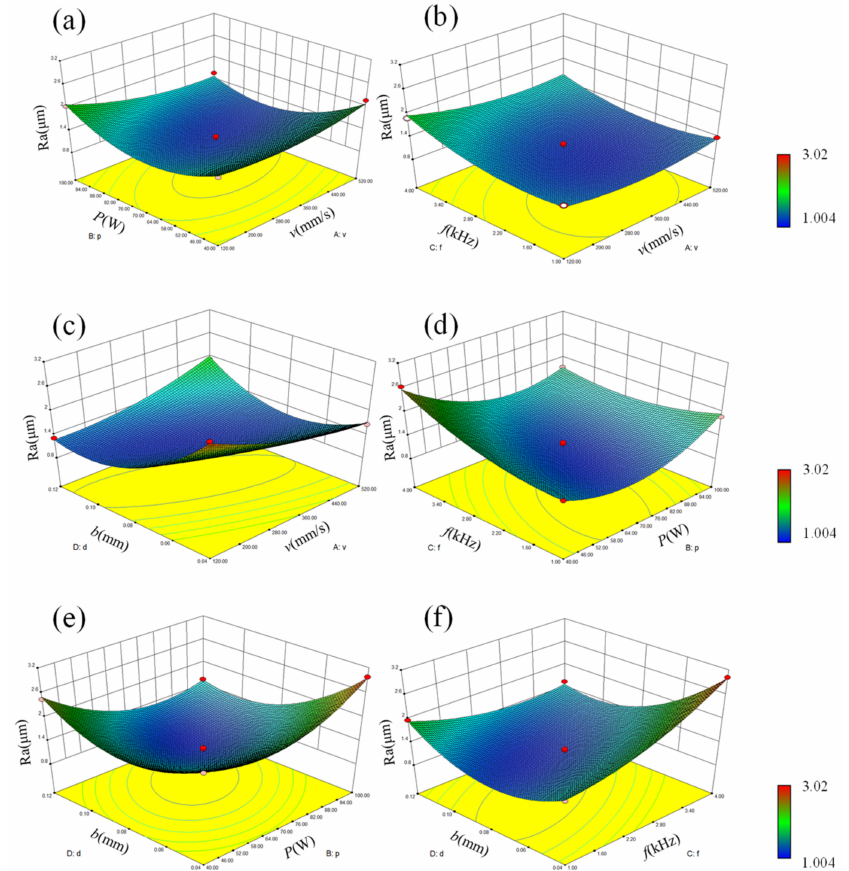
Figure 4. Effect of laser polishing interaction process parameters on surface roughness. ( a ) effect of AB interaction on surface roughness, ( b ) effect of AC interaction on surface roughness, ( c ) effect of AD interaction on surface roughness, ( d ) effect of BC interaction on surface roughness, ( e ) effect of BD interaction on surface roughness, and ( f ) effect of CD interaction on surface